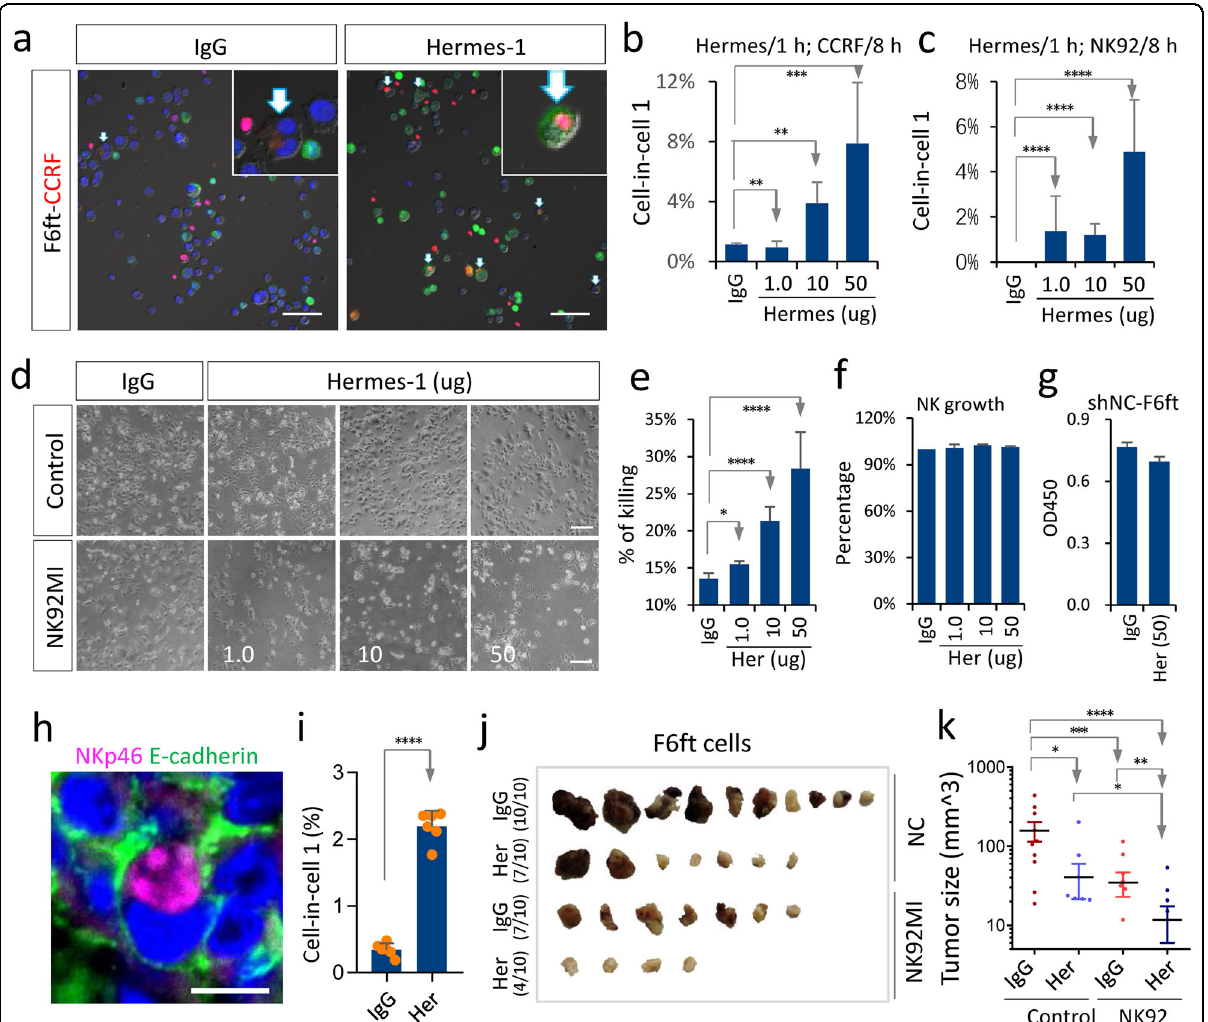
Fig. 6 Antibody-mediated blocking of CD44 increases heCIC formation and immune killing. a Representative cytospin images for heCIC formation (arrows) in F6ft (green) — CCRF-CEM (red) co-culture treated with control IgG or Hermes-1, a CD44 blocking antibody. Scale bar, 50 µm. b , c Quanti fi cation of heCIC formation between F6ft and CCRF-CEM ( b ), or NK92MI ( c ). F6ft cells were pretreated with Hermes-1 for 1 h followed by co-culture for 8 h with either CCRF-CEM cells or NK92MI cells. Data are means ± SD of six images of 20× objective. n > 800 cells analyzed for each cell. ** P < 0.01, *** P < 0.001, **** P < 0.0001. d Representative images for tumor cell killing by NK92MI cells in the presence of different amounts of Hermes- 1 antibody. Scale bar, 50 µm. e Tumor cell killing by NK92MI cells was promoted by Hermes-1 (Her) treatment. Cells were co-cultured for 8 h (E/T = 4:1) before measured by Cell Counting Kit-8. * P < 0.05; **** P < 0.0001. Data are means ± SD of triplicate assays. f , g Hermes-1 (Her) treatment had little in fl uence on the autonomous cell growth of either NK92MI ( f ) or F6ft cells ( g ). h Representative images of heCIC structures formed between F6ft cells and NK92MI cells in xenograft tumor tissues stained with antibodies against E-cadherin (green) and NKp46 (red). Scale bar, 15 µm. i Increased heCIC formation in xenograft tumor tissue treated with Hermes-1. Data are means ± SD of six images of 20× objective. **** P < 0.0001. j Four groups of tumors xenografts collected from the SCID Beige mice. Her: Hermes-1. k Quanti fi cation of xenografted tumors 21 days post the inoculation of F6ft cells together with the indicated antibodies and NK92MI (NK92) cells. Her: Hermes-1. * P < 0.05; ** P < 0.01; *** P < 0.001; **** P < 0.0001. F test was